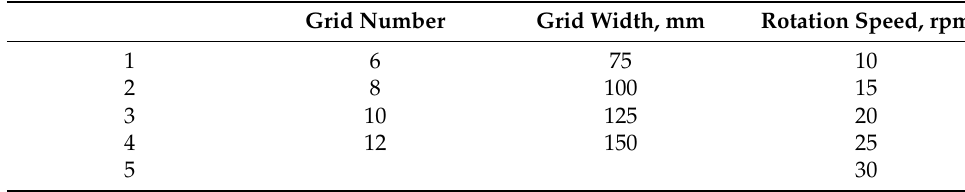
Table 2. Components and levels of the simulation tests. Grid Number Grid Width, mm Rotation Speed,